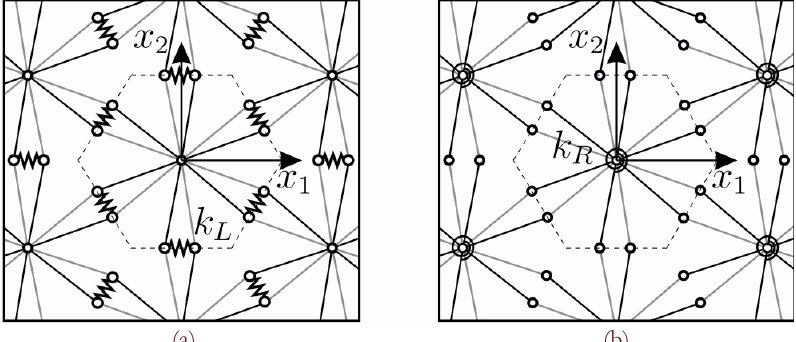
Figure 4: Lattice reinforced with elastic springs. (a) Longitudinal springs of stiffness k L . (b) Rotational spring of stiffness k R . The dashed contour indicates a typical unit cell of the periodic elastic